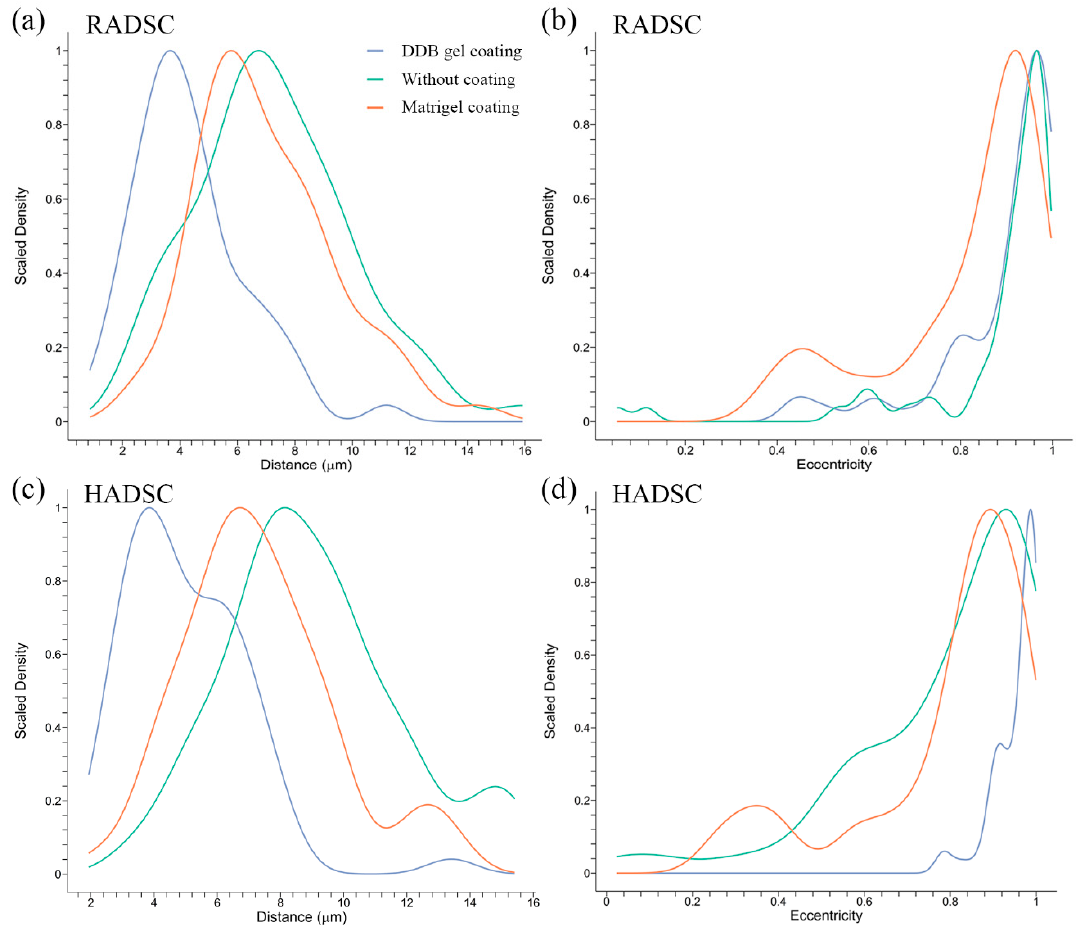
Figure 5. Cell-to-cell distances and eccentricity index statistical analysis of rabbit ADSC (RADSC) and human ADSC (HADSC) . Cells were grown for 72 h without coating (green) and with coating of Matrigel (red) or DDB bladder gel (blue): ( a ) cell distances between RADSC; ( b ) eccentricity of RADSC; ( c ) cell distances between HADSC; and ( d ) eccentricity of HADSC.